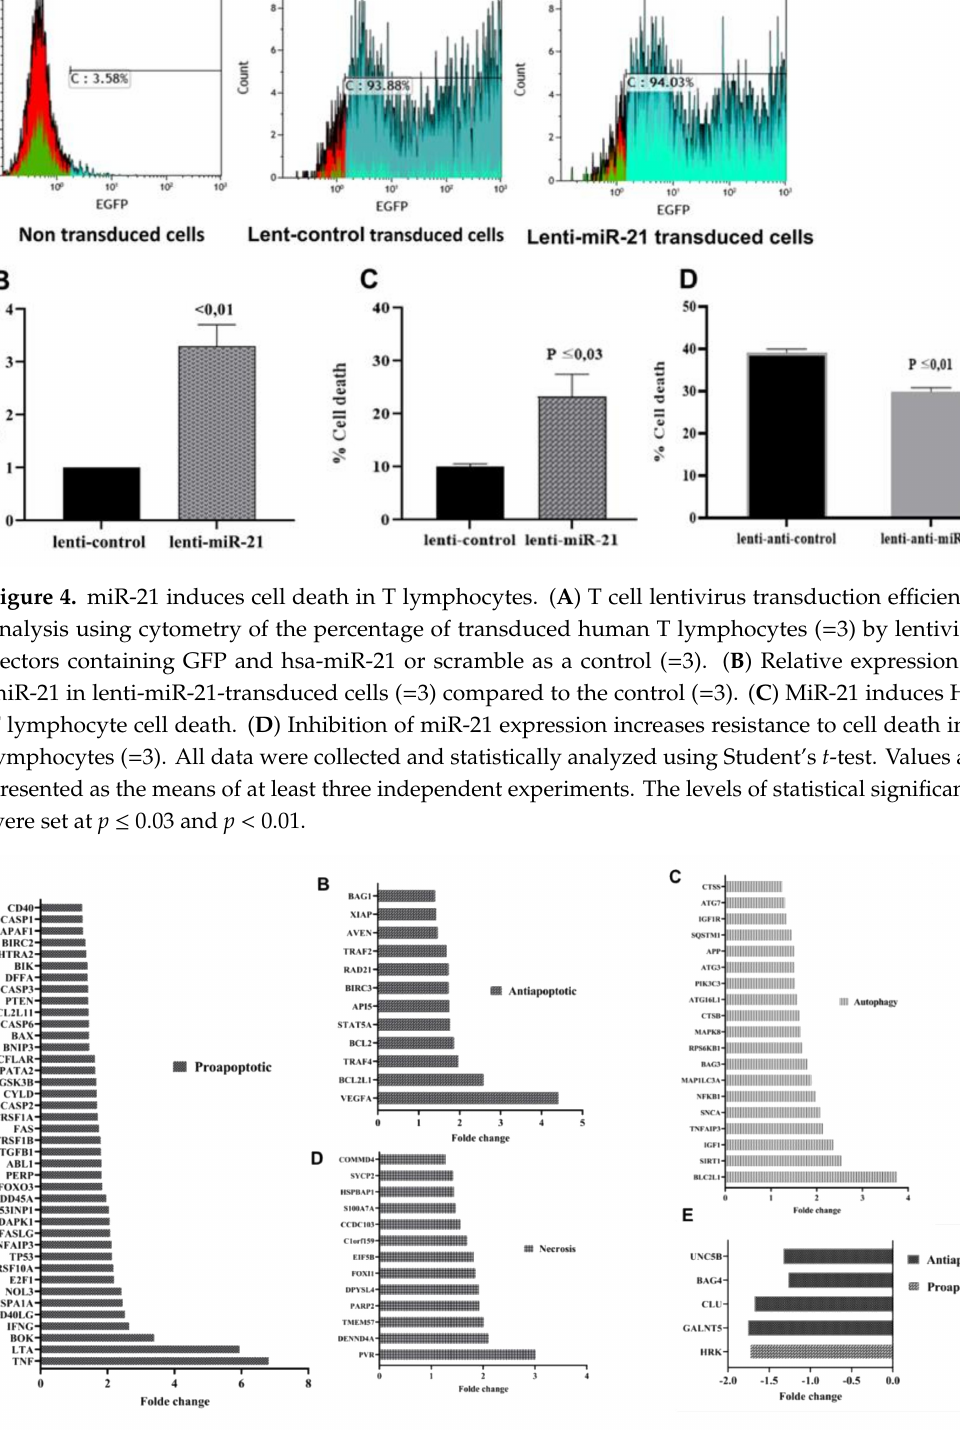
Figure 5. Gene expression analysis of cell death pathways induced by miR-21 ( A – E ). Analysis of the gene expression of cell death pathways in lenti-miR-21-transduced T lymphocytes ( = 3) compared to lenti-scramble-transduced T lymphocytes ( = 3). Relative expression of upregulated proapoptotic ( A ), antiapoptotic ( B ), autophagy ( C ), necrosis ( D ), and downregulated genes ( E ). All data were collected and statistically analyzed using Student’s t -test. The level of statistical significance was set at p <